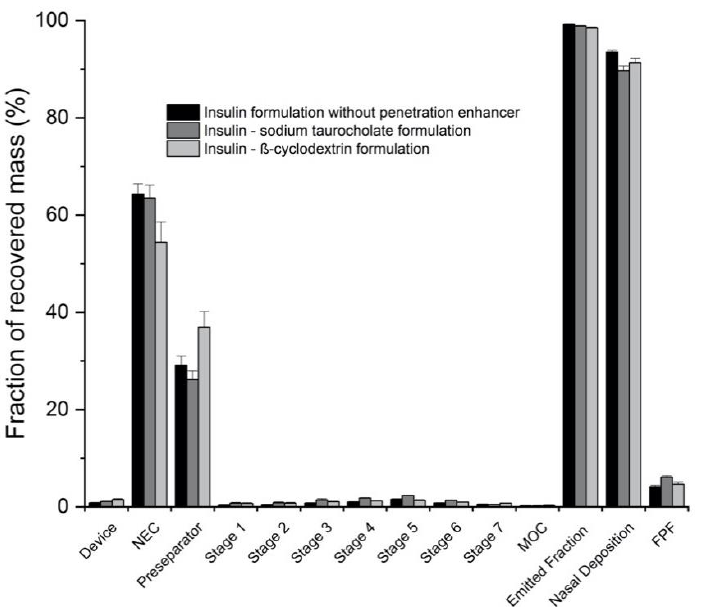
Figure 4. Results of the NGI experiments analyzing the nasal deposition of the insulin loaded SFD particles with different penetration enhancers ( n = 3).